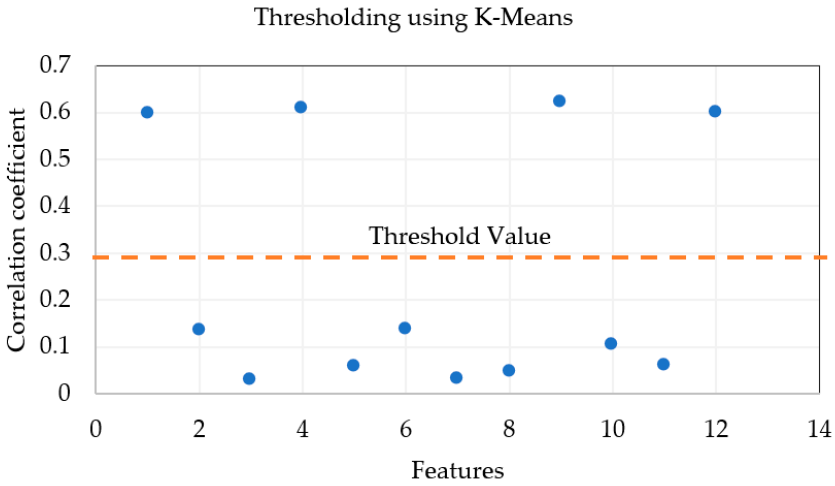
Figure 2. Thresholding of correlation co-efficient using K-means.